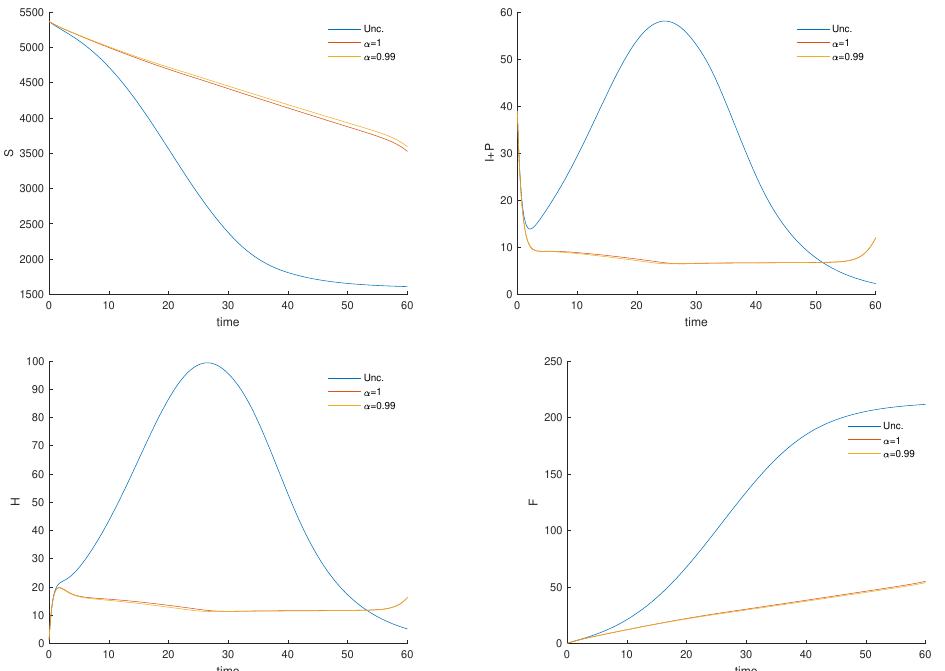
Figure 8. Evolution of susceptible individuals S (top left), symptomatic infected individuals I + P (top right), hospitalized individuals H (bottom left), and fatalities F (bottom right) for the solutions of the uncontrolled model (2) and the optimal solutions of the FOCP (4)–(7) with fractional-order derivatives α = 1.0 and α = 0.99 and the parameter values of Table 1. The corresponding Pontryagin controls are shown in Figure 9.